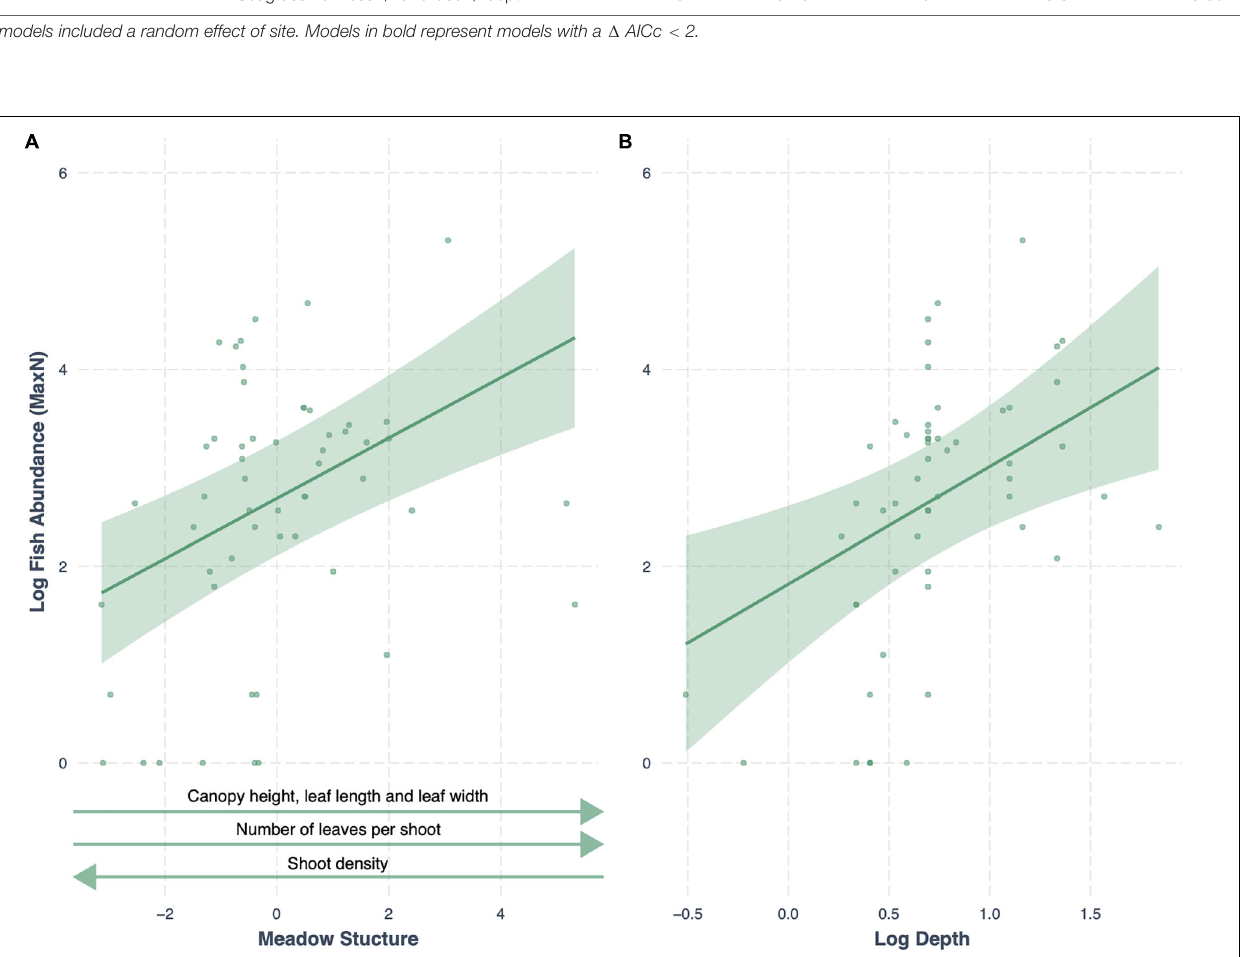
Frontiers in Marine Science |